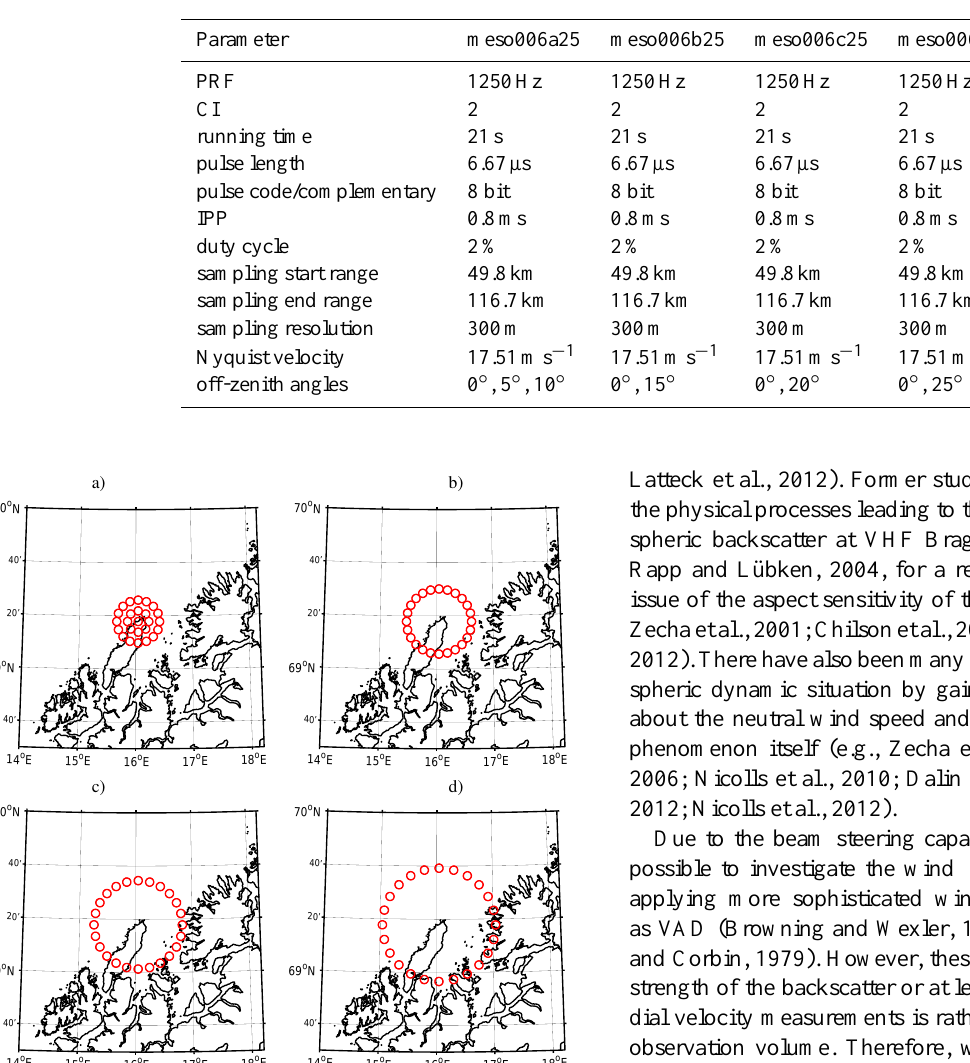
Table 1. Experiment configuration for all four experiments. The abbreviations stand for: CI – coherent integration, PRF – pulse repetition frequency, IPP – inter-pulse period.